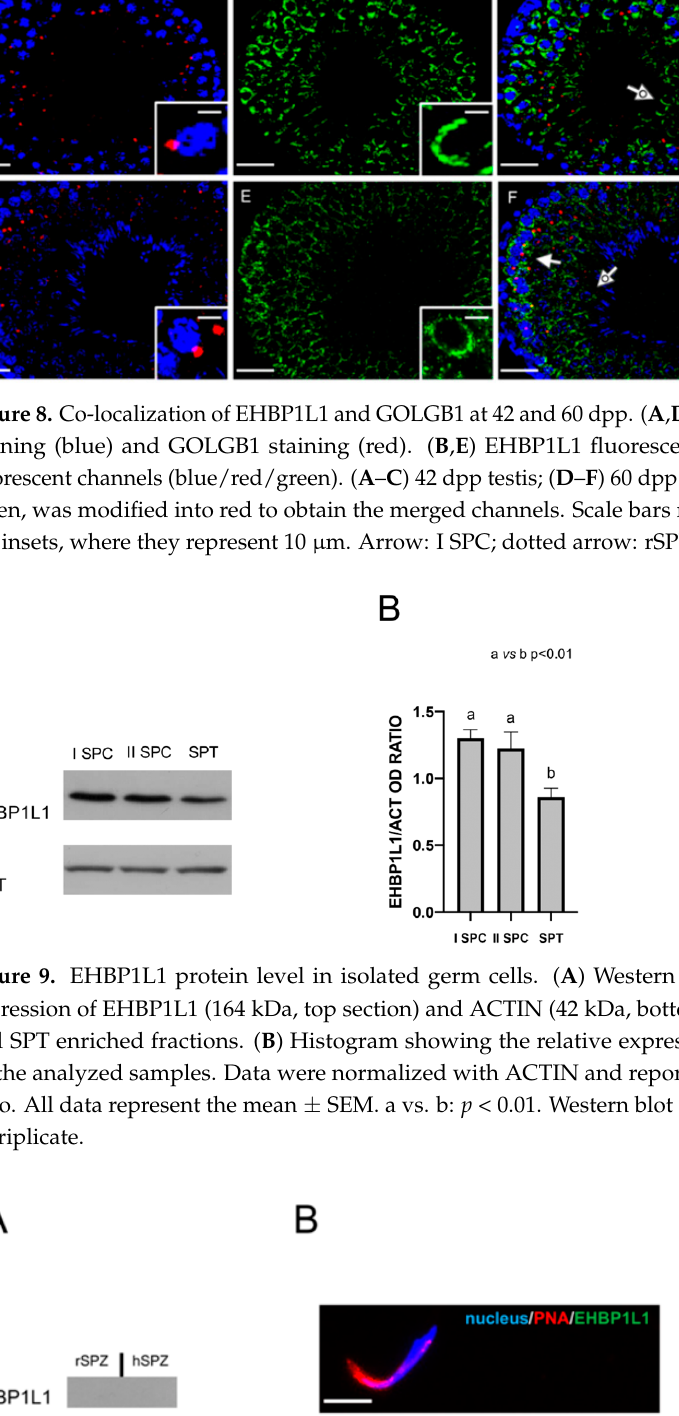
eSPT was negative for both proteins (asterisk, Figure 8F).